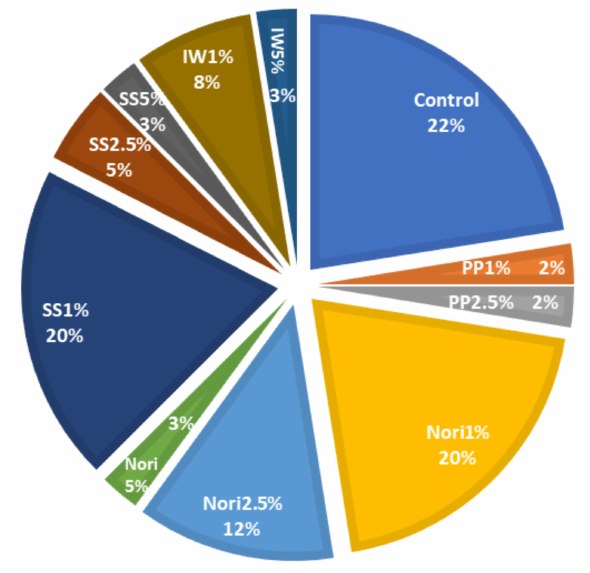
Figure 1. Pie chart representing consumer ( n = 25)